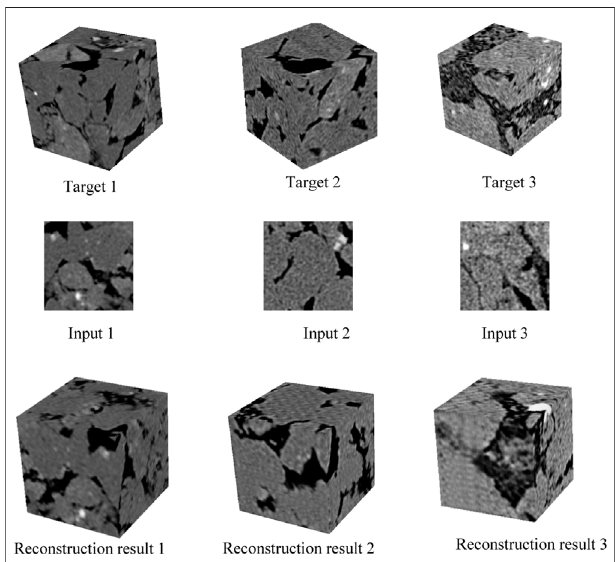
FIGURE 4 | Schematic diagram of CPGAN reconstruction results.